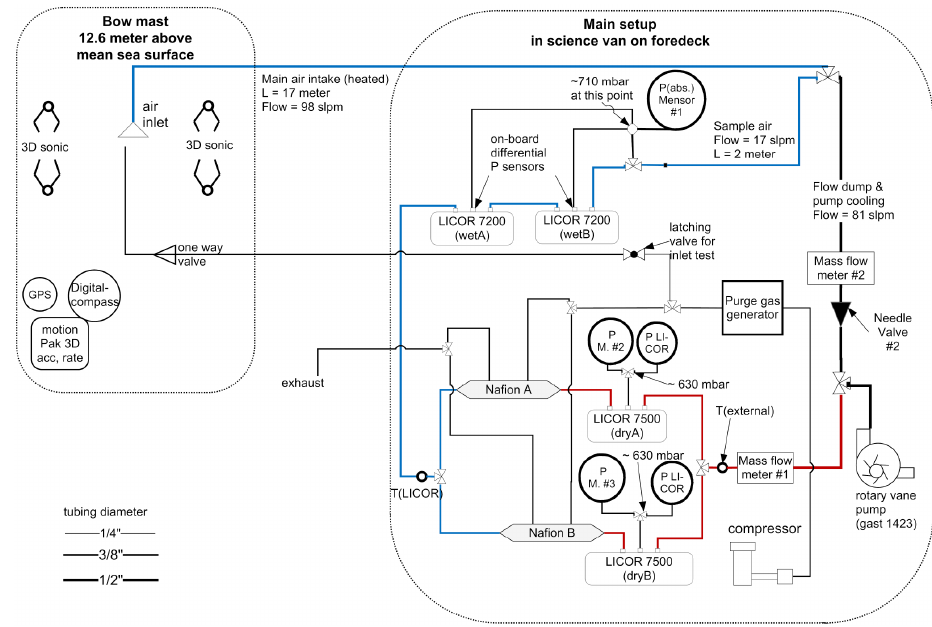
Fig. 1. Schematic of the eddy covariance setup for the SOAP experiment on the R/V Tangaroa . The sample air line is colour-coded in blue, and the colour is changed to red downstream of the membrane dryers to indicate that the air is dried at this point.